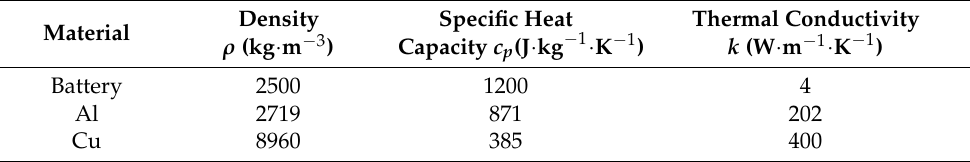
Table 2. Thermo-physical properties of Battery and casing materials [27].